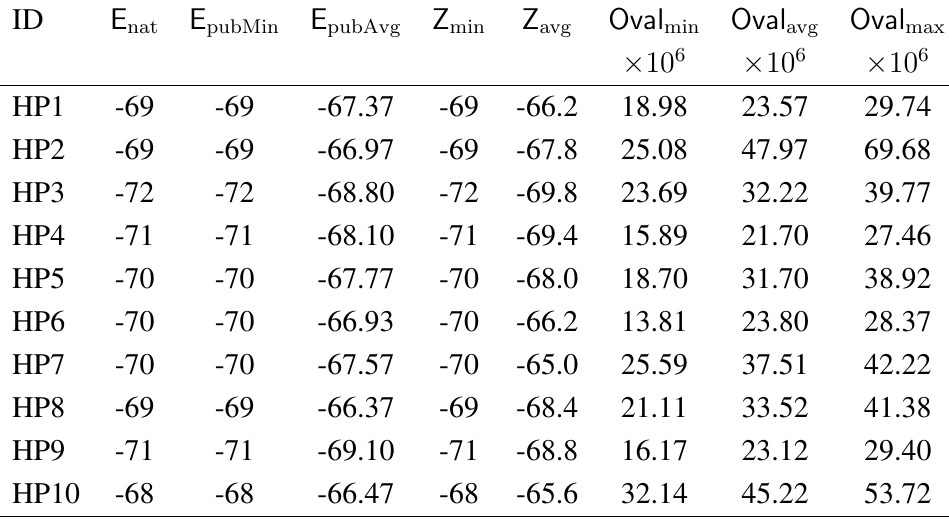
Table 5. Results for the H-P model on 3D FCC lattices for benchmarks from Table 1. E and E are the published minimum and average results from [53]. Published energy pubAvg function evaluation counts are not